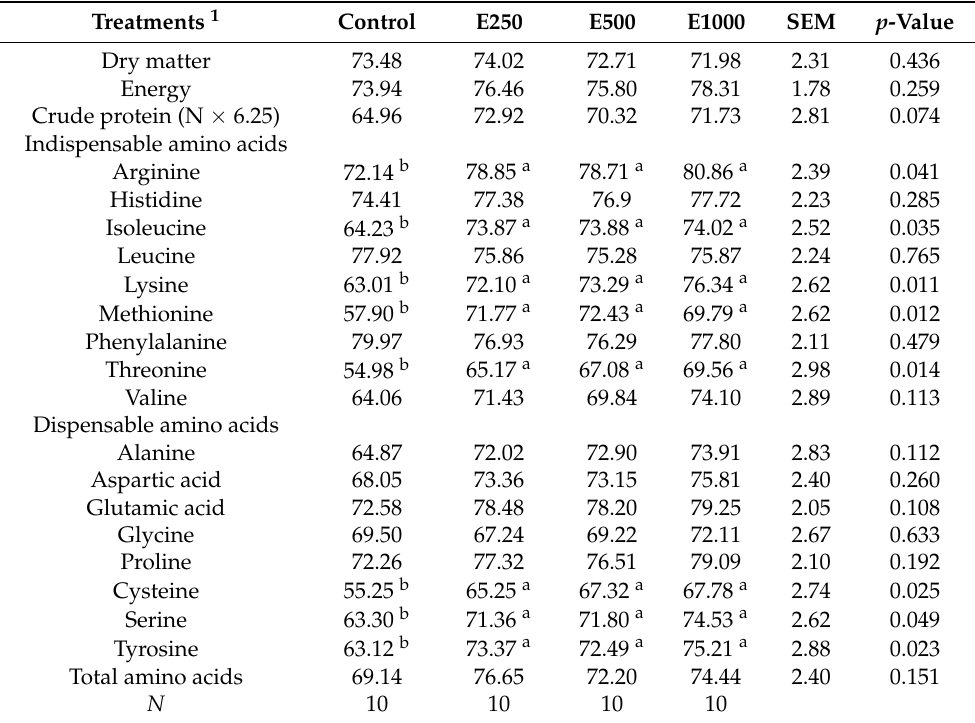
Table 3. Effect of glucose oxidase addition on the apparent ileal digestibility of nutrients in the grower broilers (%).